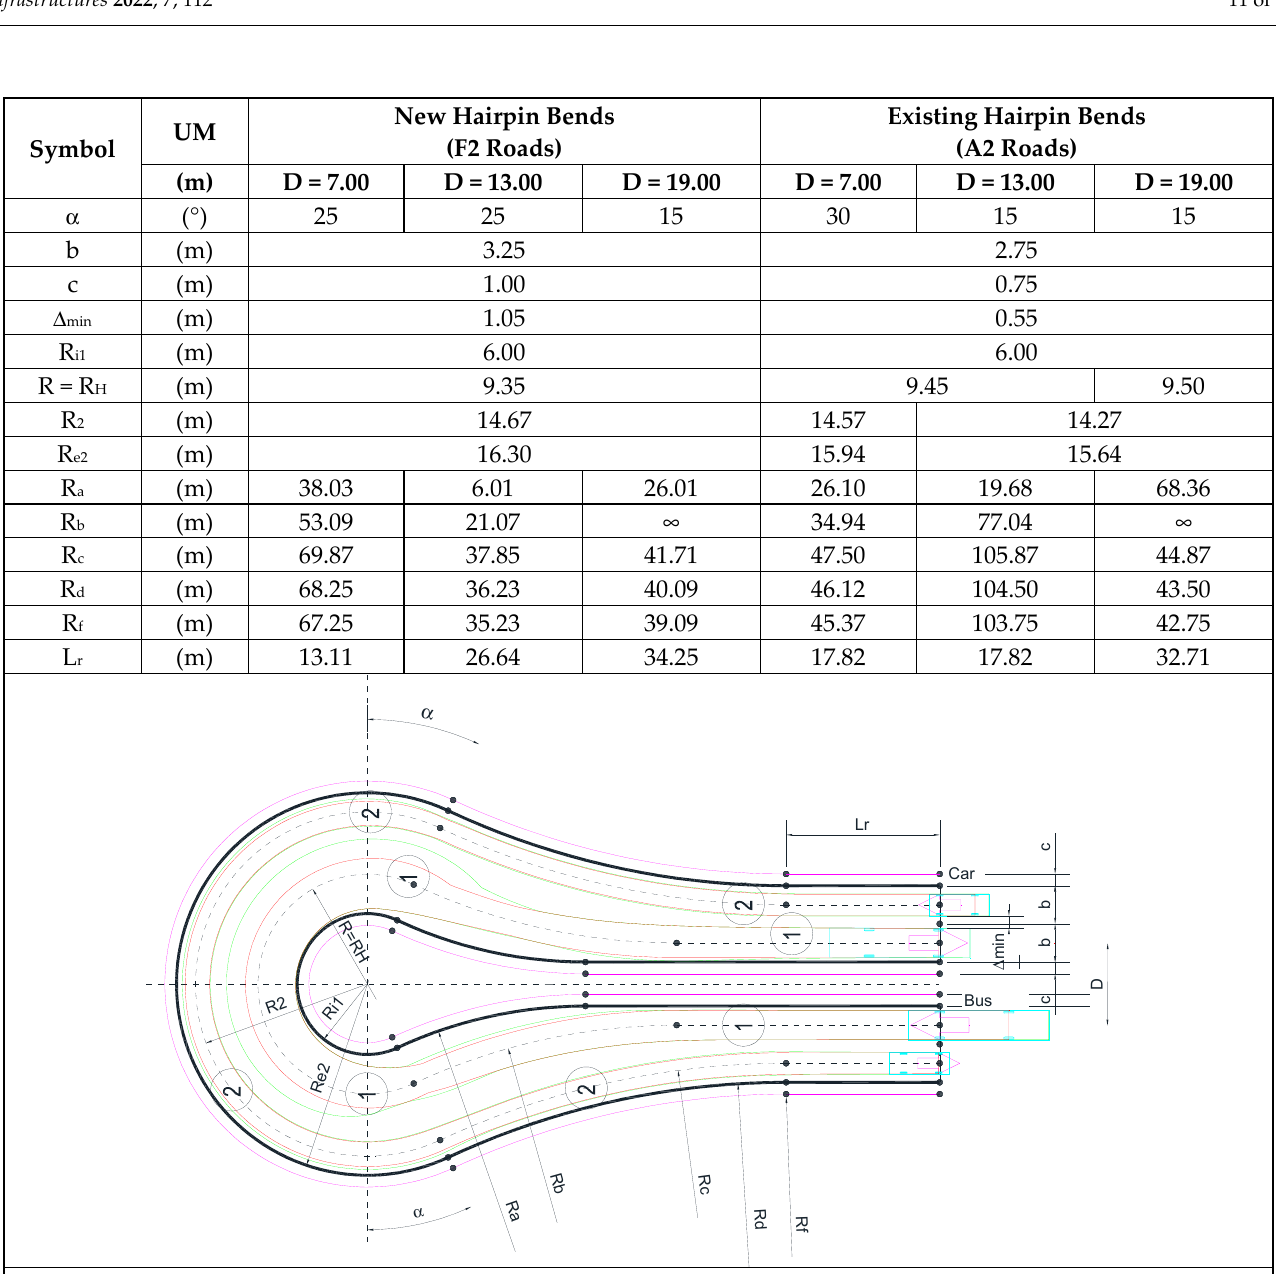
Figure 8. Italian hairpin bends geometry (new and existing).